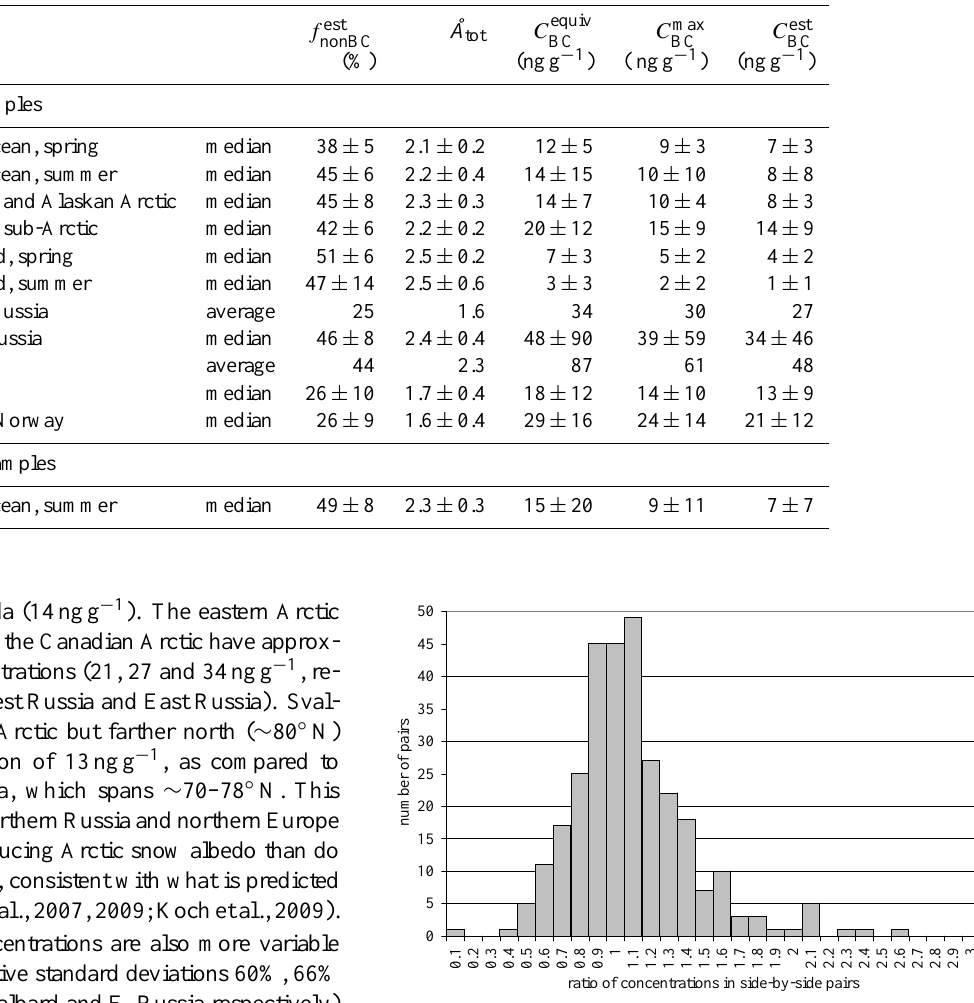
Fig. 6. Side-by-side samples were taken at the surface and through- out the vertical column for the sampling sites in East and West Russia, the Canadian Arctic and at Tromsø, Norway. Shown is a histogram of the left/right ratios of C est for paired samples. The BC average 1- σ spread in the ratios was ± 0.27 for Tromsø, ± 0.34 for the Canadian Arctic and ± 0.42 for